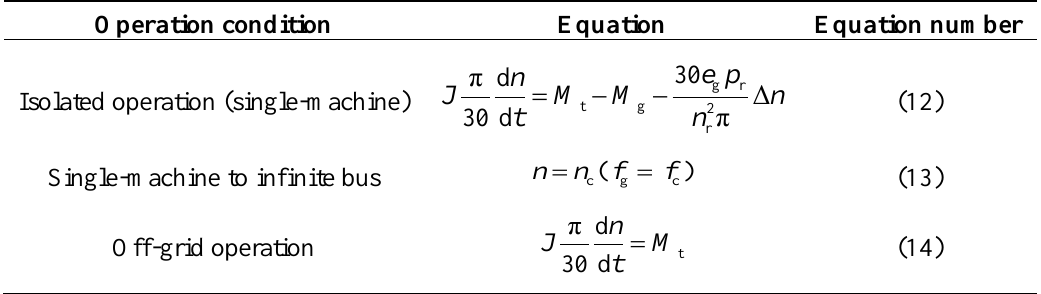
Table 2. Equations of generator model under different conditions.